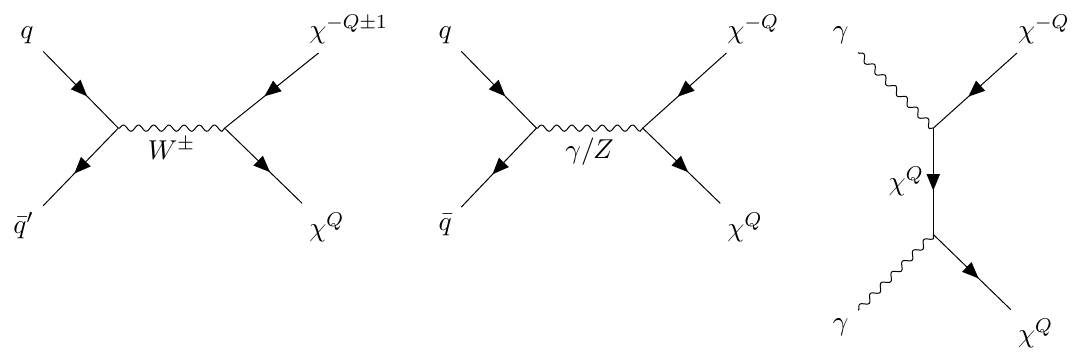
Figure 1 . Representative Feynman diagrams for the production of the exotic fermions: charged- current (left), neutral current (middle) and photon-photon fusion (right)